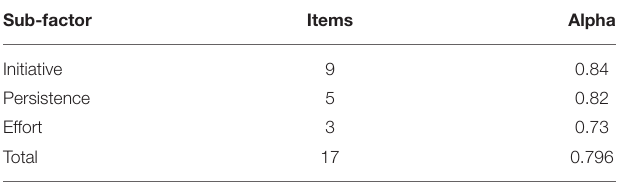
TABLE 1 | Cronbach’s alpha coefficients for GSEQ. Sub-factor